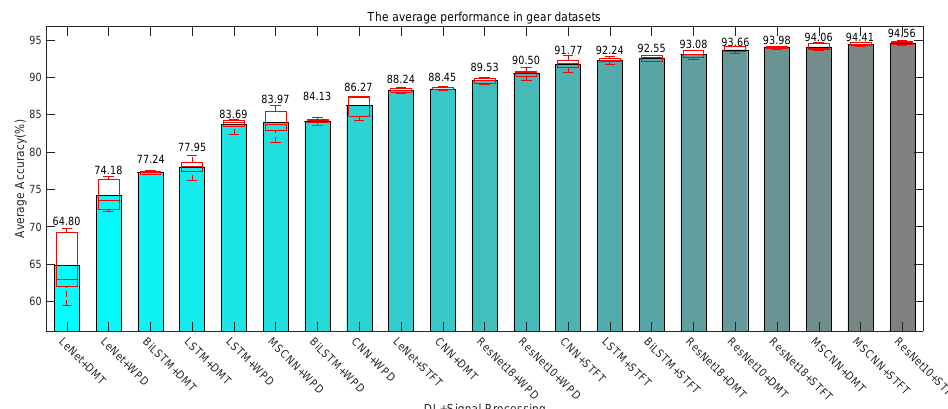
Figure 10. The results of the bearing datasets.